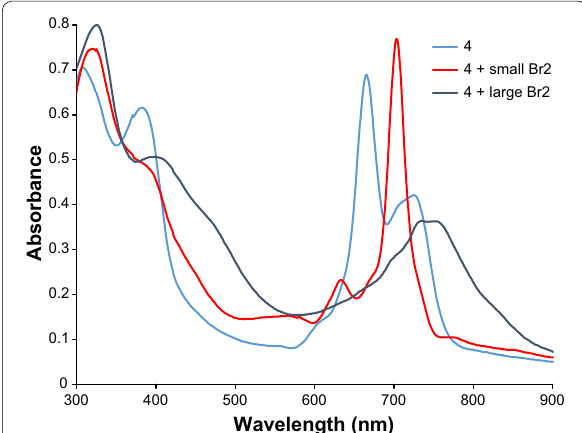
Fig. 1 UV–vis spectra of rare-earth bisphthalocyanines 2 – 4 in DMF at 10 mg l − 1